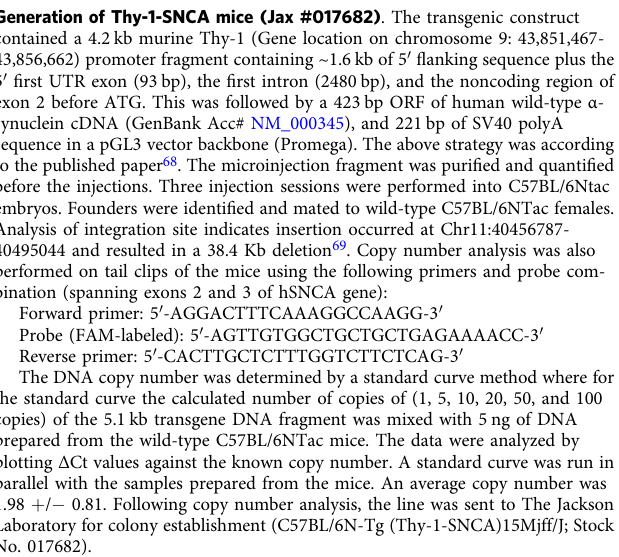
Fig. 2 using FACSDiva v8.0.1 (BD Biosciences). In an initial validation step, microglia from Cx3cr1 CreER-IRES-Eyfp were stained with CD45 and CD11b anti- bodies and the ratio of CD11b High /CD45 Intermediate cell population among EYFP- positive cells, and vice versa was checked by setting each other ’ s cell population as a parent gate as shown in Supplementary Fig.